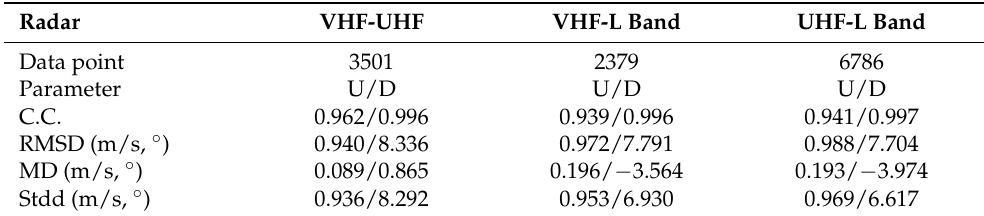
Table 3. Comparisons of horizontal wind velocity (U) and wind direction (D) between wind profilers in the absence of